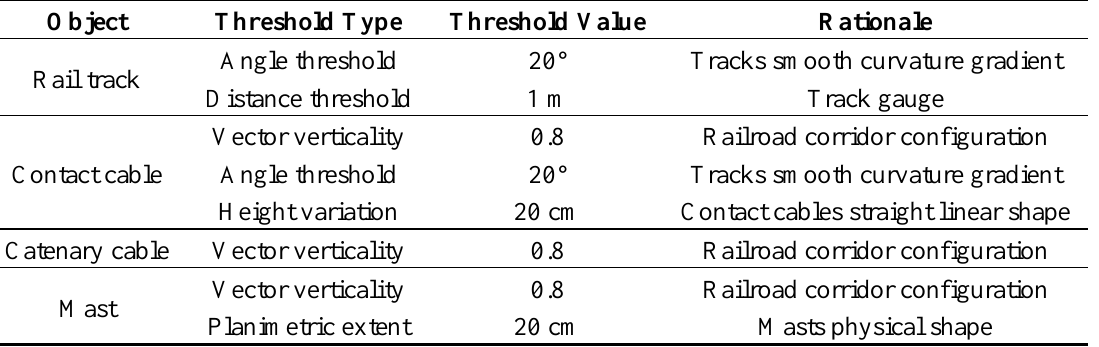
Table 5. Types and rationale of thresholds used in this